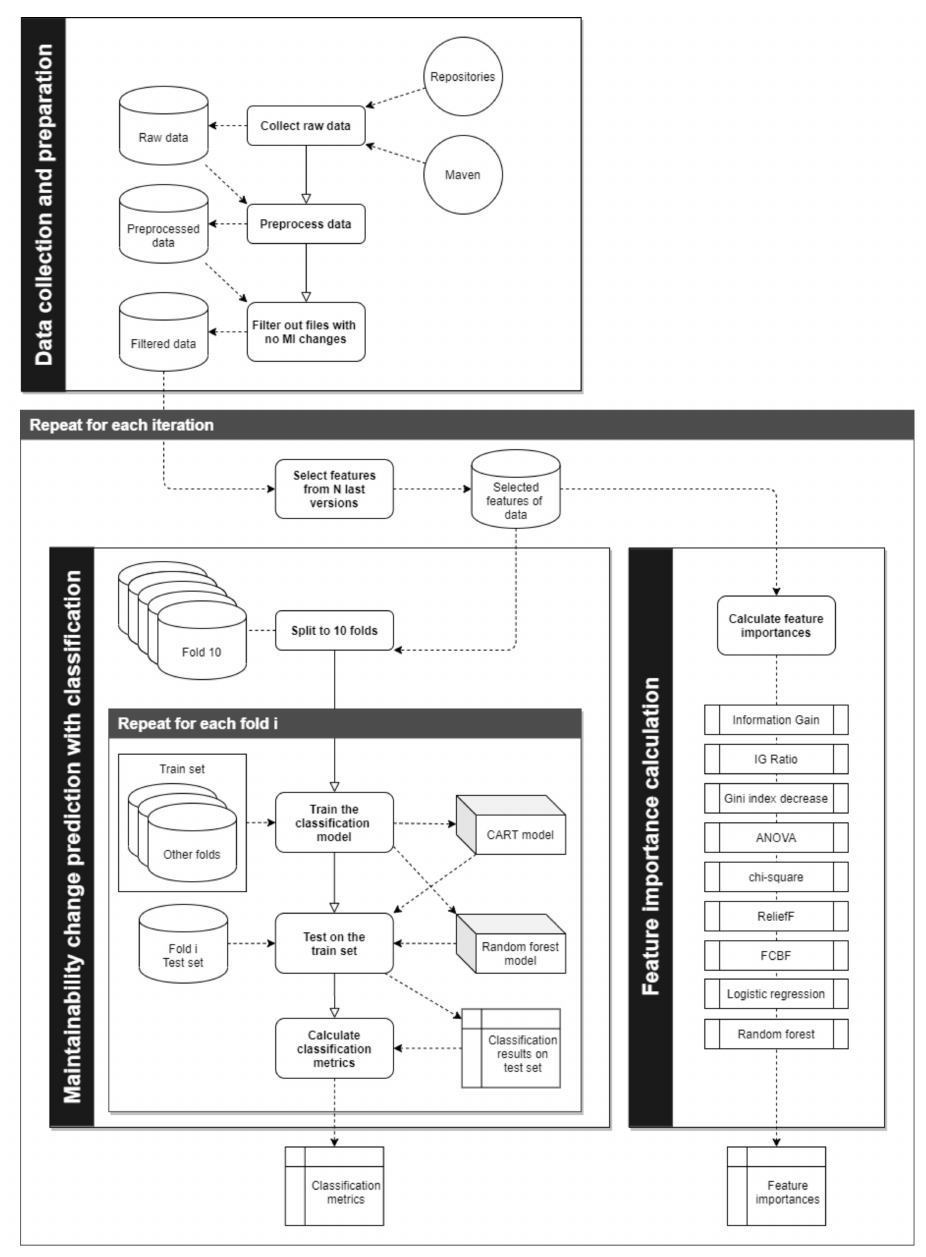
Figure 5. The whole process of the experiment.